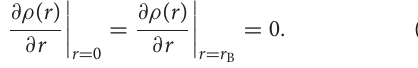
pp elastic + 14.24 MeV, with =